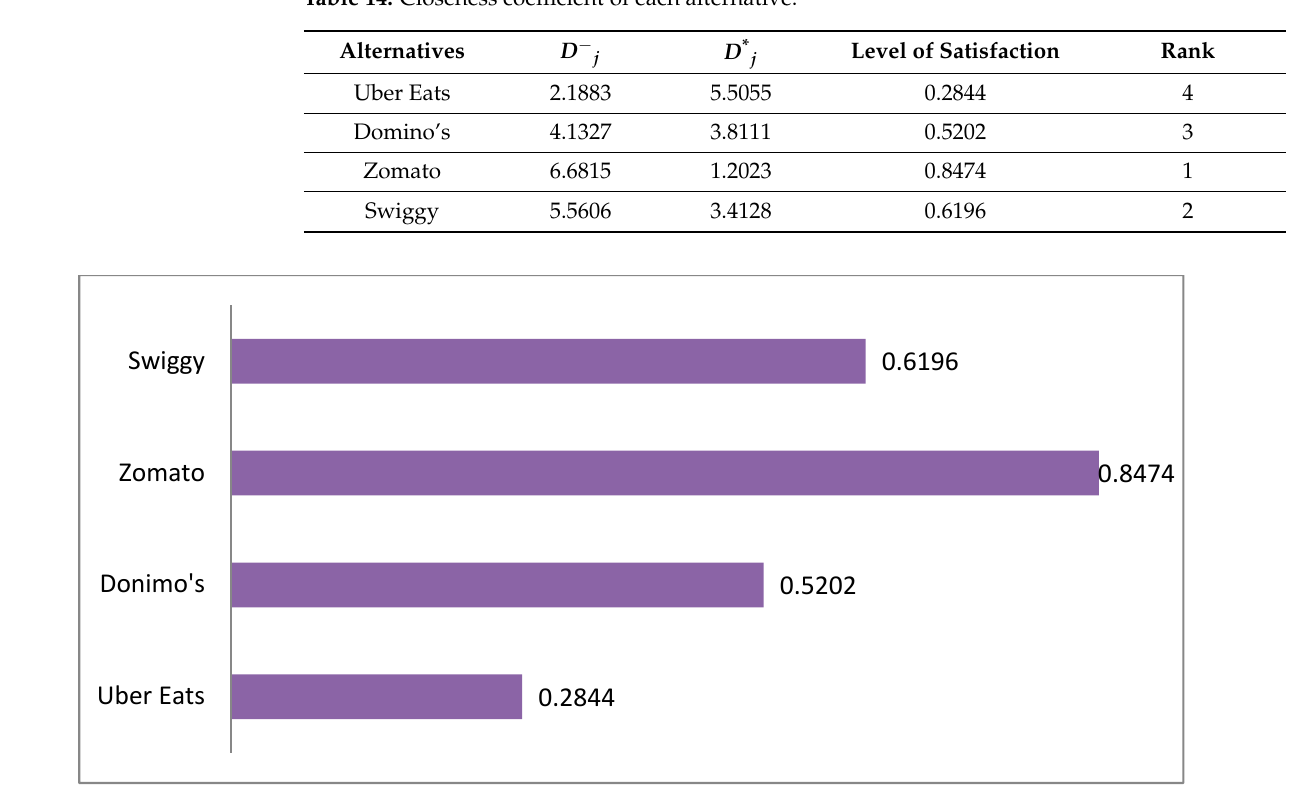
Table 14. Closeness coefficient of each alternative.